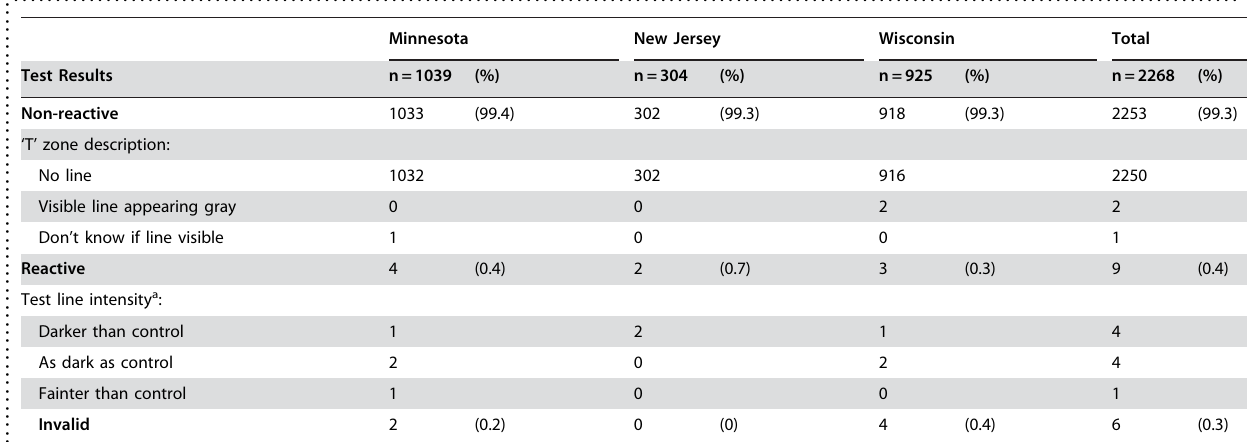
Table 3. OraQuick Advance rapid HIV antibody test results for 2268 clients tested with oral fluid, Incidence Study, February 2005